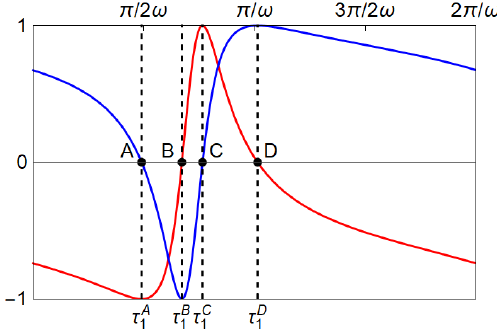
Figure 2. Graphs of M ( (cid:28) 1 ) (red) and N ( (cid:28) 1 ) (blue). The interval [0 ; 2 (cid:25)=! ] is divided into (cid:133)ve subintervals, in each of which the signs of cos !(cid:28) 2 and sin !(cid:28) 2 are determined. Solving the equations in (24)